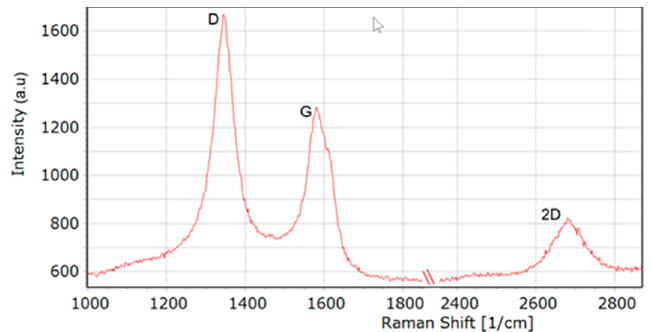
Figure 3. Raman spectra of MW-CNTs used in the experiment.